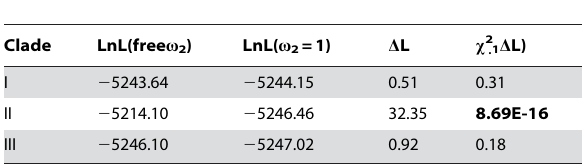
Table 3. Test of positive selection of the rrgA gene.